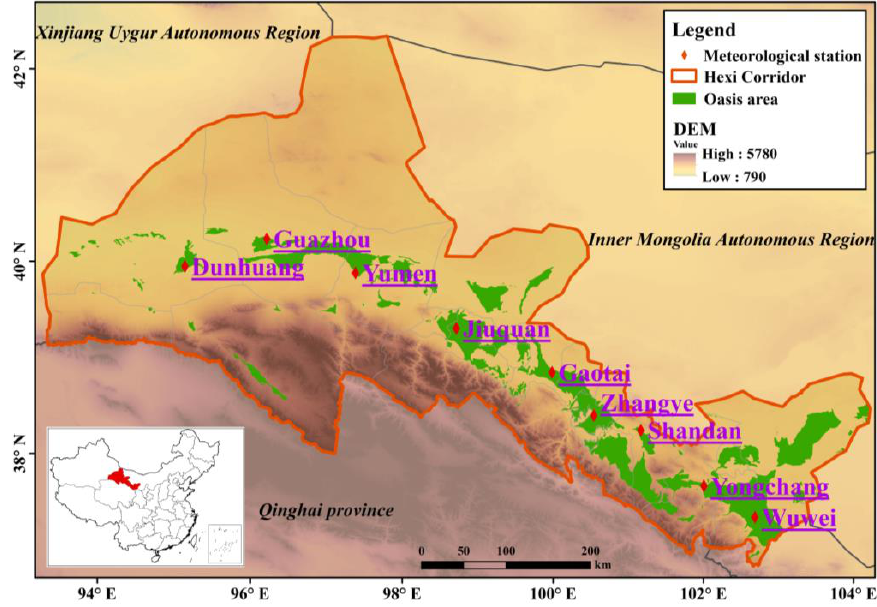
Figure 1 . Location of the nine meteorological stations in Hexi Corridor, northwest China. Figure 1. Location of the nine meteorological stations in Hexi Corridor, northwest